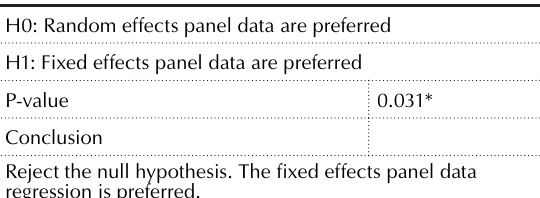
Table 2. Results of the Hausman